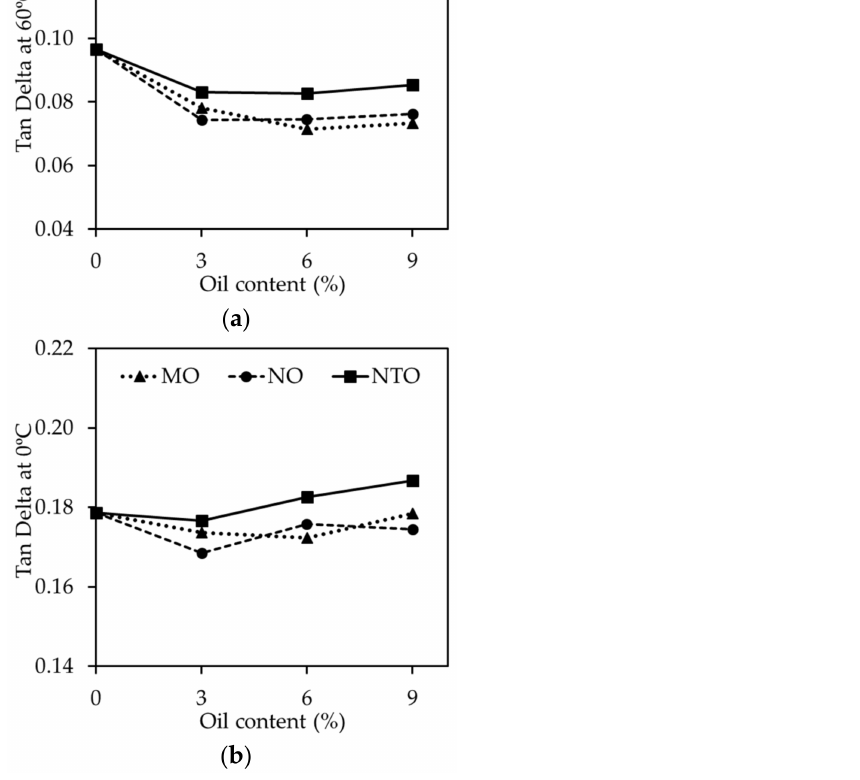
Figure 8. ( a ) tan δ at 0 ◦ C and ( b ) tan δ at 60 ◦ C of the NRCs comprising different oil types